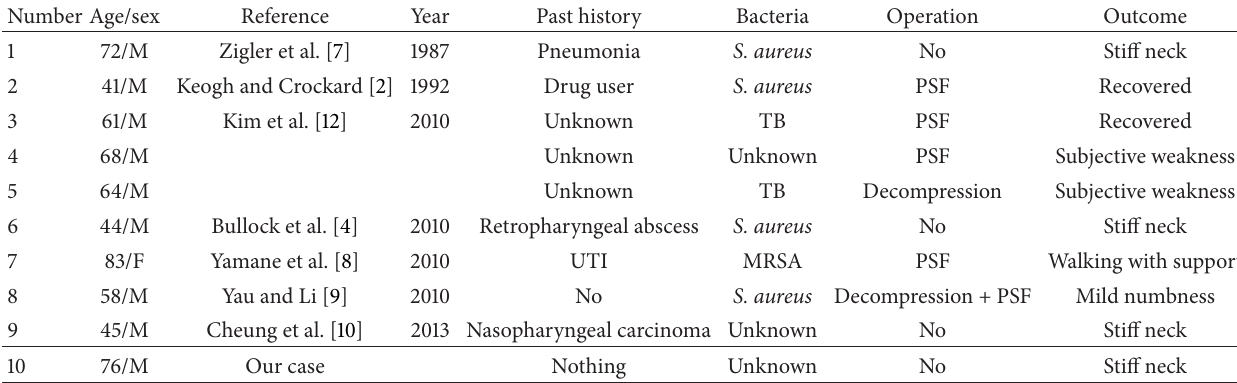
Table 1: Case reports of atlantoaxial subluxation of pyogenic spondylitis around odontoid process with neurological deficits.